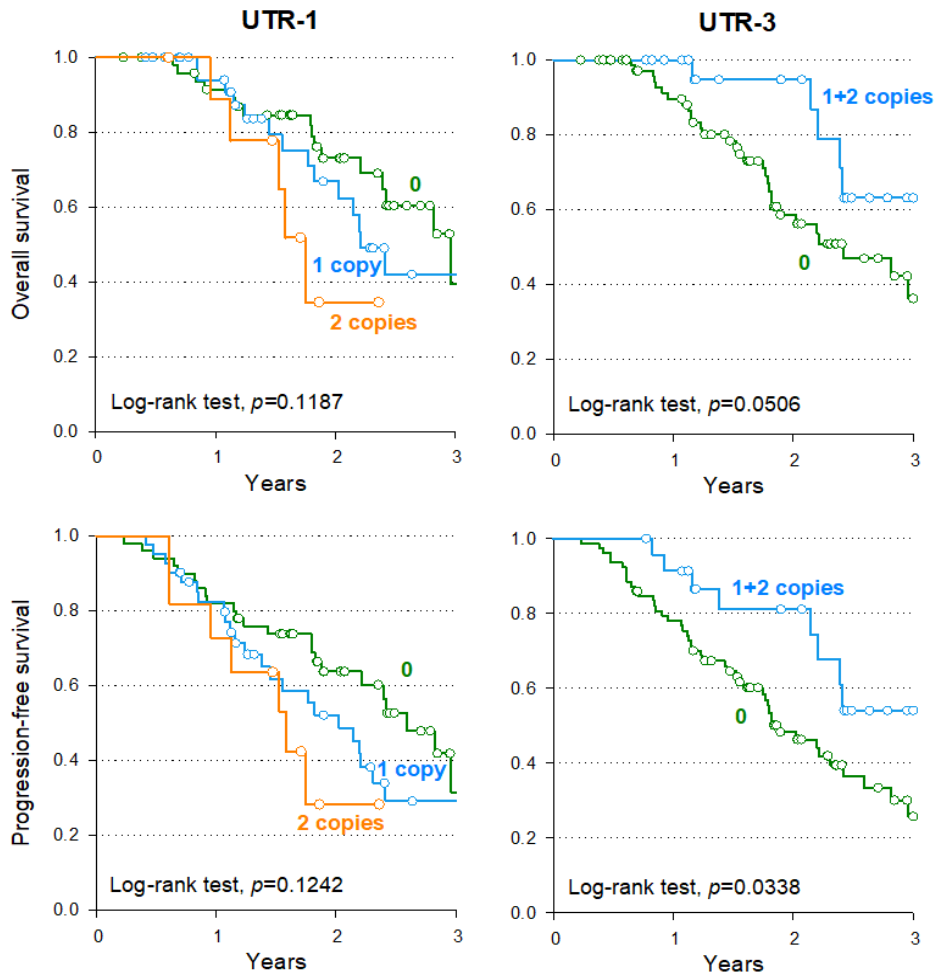
Figure 4. Kaplan – Meier estimates of overall survival and progression-free survival related to the most significant HLA-G haplotypes in patients achieving a complete or partial response to treat- ment.